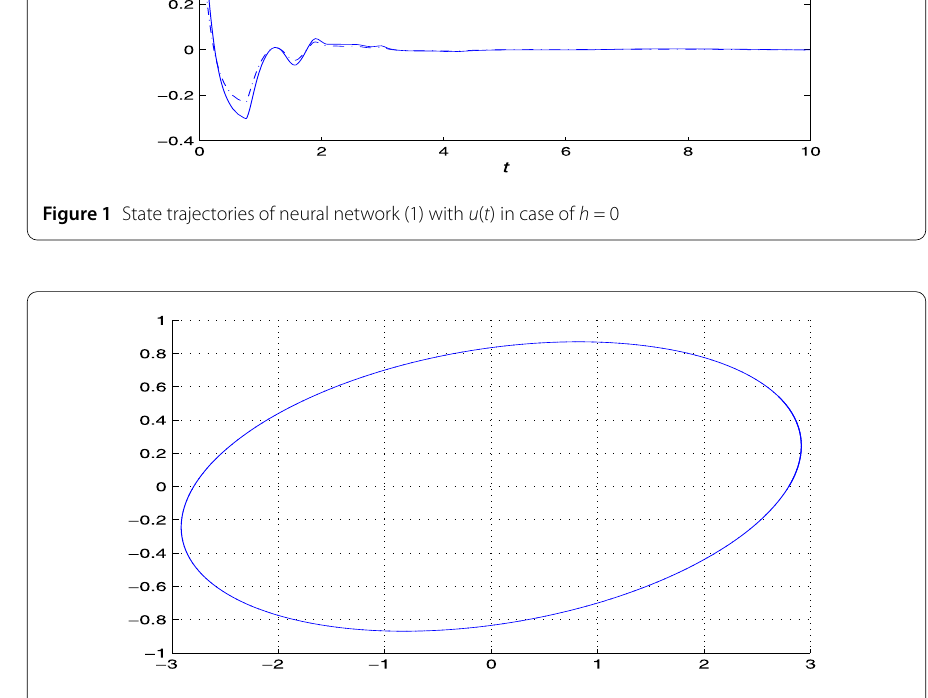
Figure 2 The disturbance attenuating controller u ( t ) = – Fx ( t ) with an attractor as (cid:14) = { x | x T Qx ≤ 1